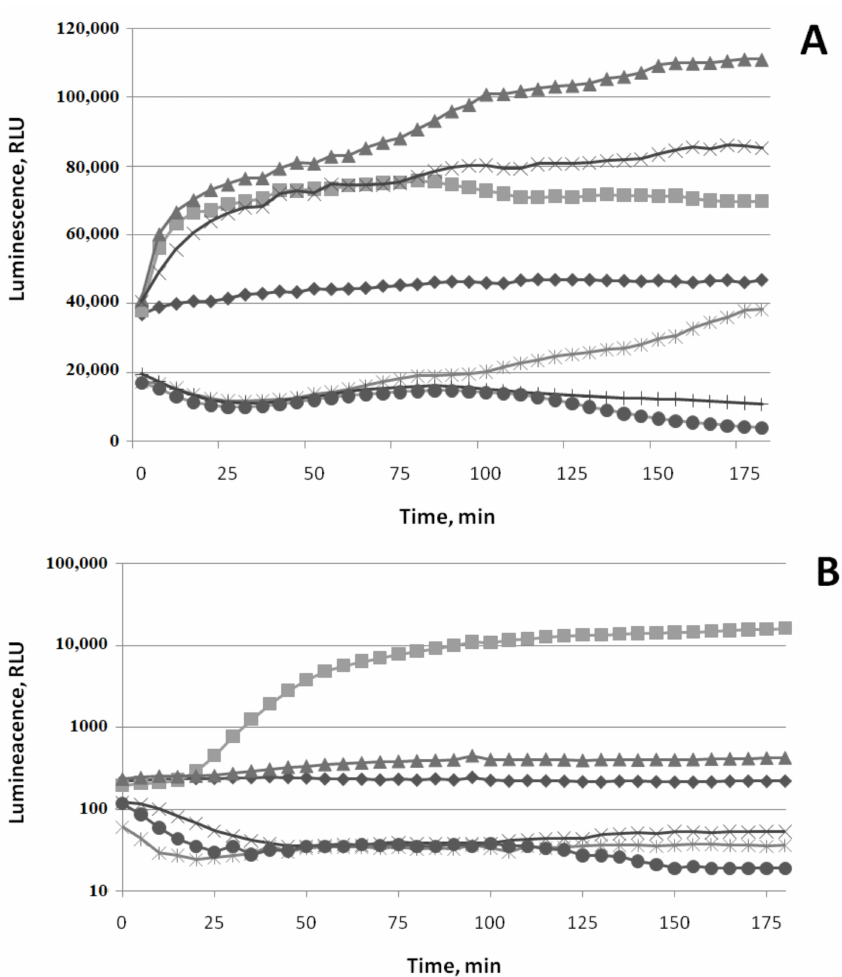
Figure 2. Luminescent response of strain E. coli MG1655 (pKatG’::lux) to hydrogen peroxide ( A ), ( − )-limonene ( B ), and (+)- α -pinene (C). Time course of mean values of light emission (in RLU) in the presence of different chemical concentrations ( A , B ): ( ) 0 µM (black diamond—Control), ( ) 1 µM (gray square), ( ) 5 µM (dark triangle), (×) 25 µM (black cross), ( ) 50 µM (gray asterisk), and ( ) 100 µM (light circle); (C): ( ) 0 µM (black diamond—control), ( ) 5 µM (light square), ( ) 50 µM (gray triangle), ( ) 100 µM (black circle).